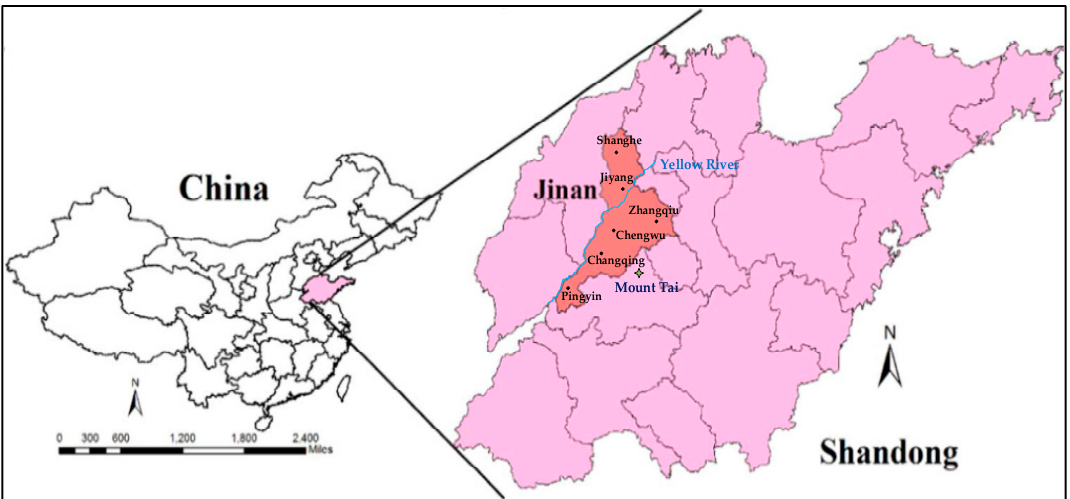
Figure 2. Location of Jinan in Shandong Province, China.